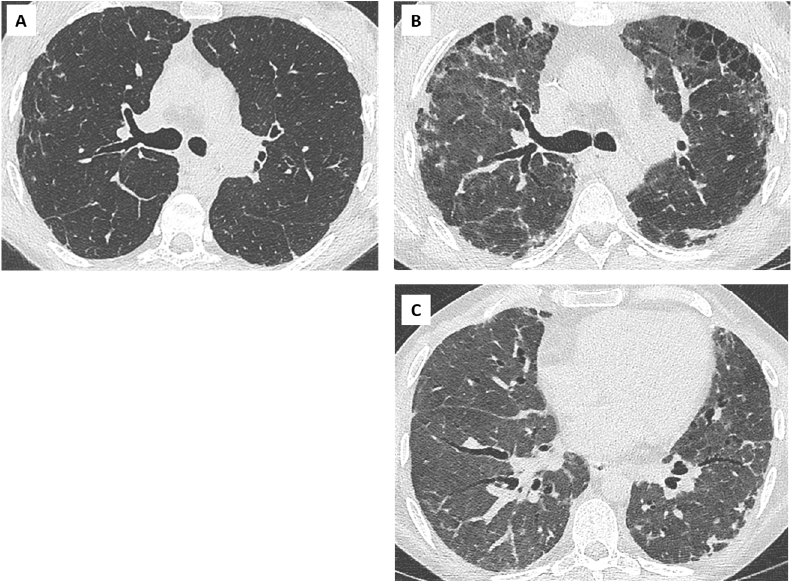
Figure 4. Diffuse opacities associated with RAS in a 38-year-old woman showing slowly progressive clinical symptoms and functional decline. ( A ) CT scan at CLAD onset, showing subtle reticular changes in the right upper lobe; ( B ) 2 years later, the patient has developed upper and subpleural predominant consolidation and reticulations, associated with paraseptal emphysema. Note the diffuse ground glass opacities consistent with inflammation and a possible NSIP pattern ( C ).